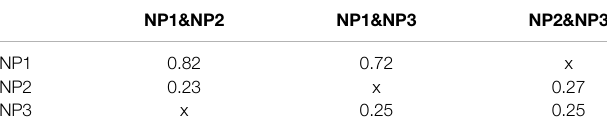
TABLE 5 | Correlations between observed data and model predictions in Experiment 1, by items. *indicates signi fi cance at or below 0.001. Bayes Mirror